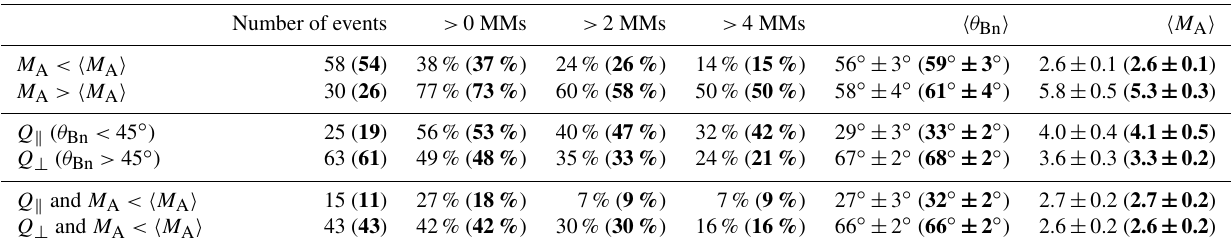
Figure 8. Probability of a near-shock sub-region containing more than four MMs in one-dimensional bins of corresponding shock parameters. Probability is defined as the ratio of the number of the near-shock sub-regions containing more than four MMs to the total number of the near-shock sub-regions within each bin. The ratio is also given as a fractional number above each bin. Table 6. Probability of a near-shock sub-region to contain a different number of MMs. The near-shock sub-regions are divided into different sub-groups according to the associated shock parameters. The average θ Bn and M A values of each sub-group are also shown. The values in bold in brackets are the corresponding values when the sheaths whose shock had 0 ◦ < θ Bn < 20 ◦ and M A > 8 were omitted from the analysis (see Fig. 7). The errors are defined by